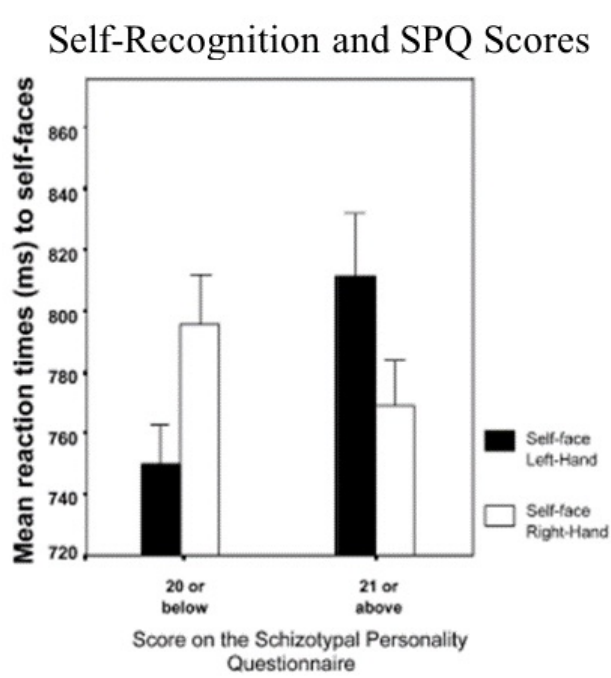
Figure 2. Effect of SPQ scores on self-face recognition reaction times.